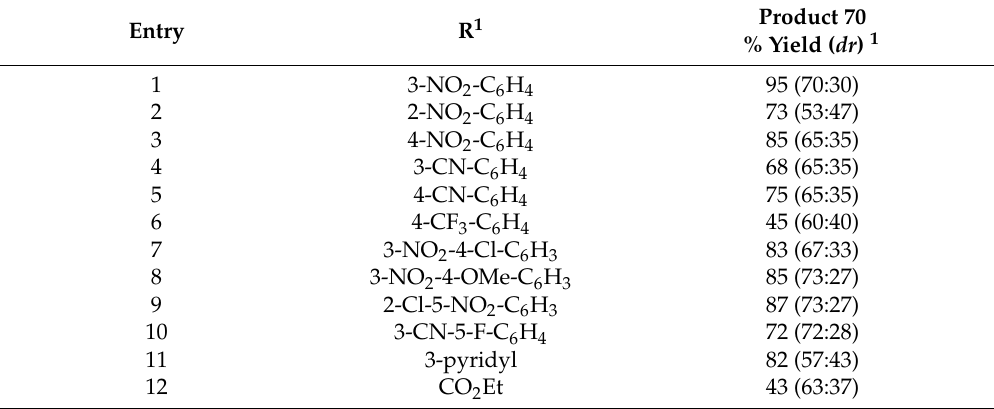
Table 9. Domino decarboxylative condensation, [3 + 2] cycloaddition and ring-opening aromatization process to give N - β -hydroxyethyl pyrroles 70 (Scheme 16).